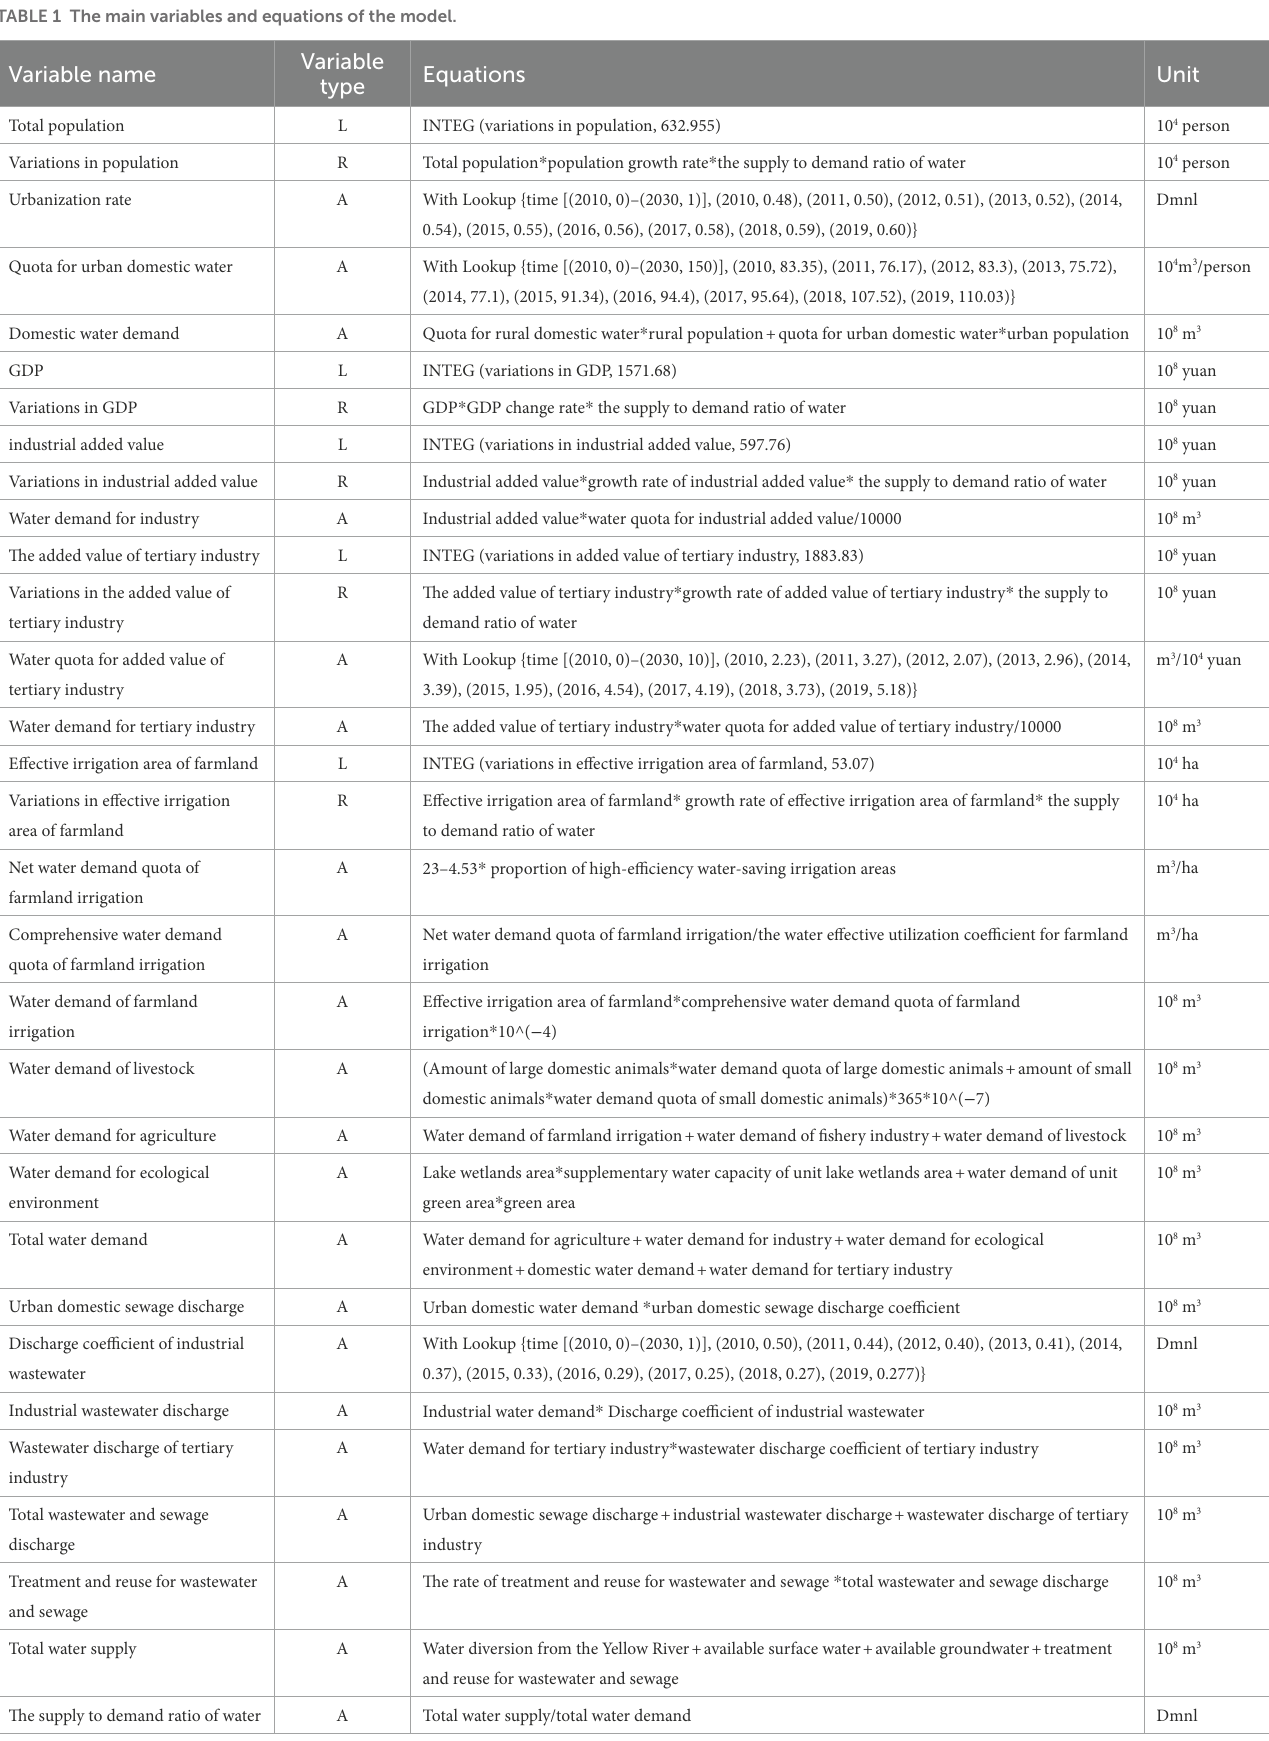
TABLE 1 The main variables and equations of the